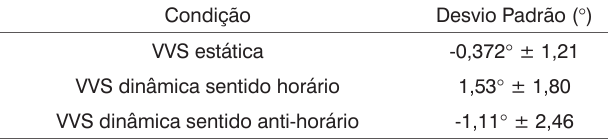
Tabela 1. Médias e DP em cada condição de VVS.